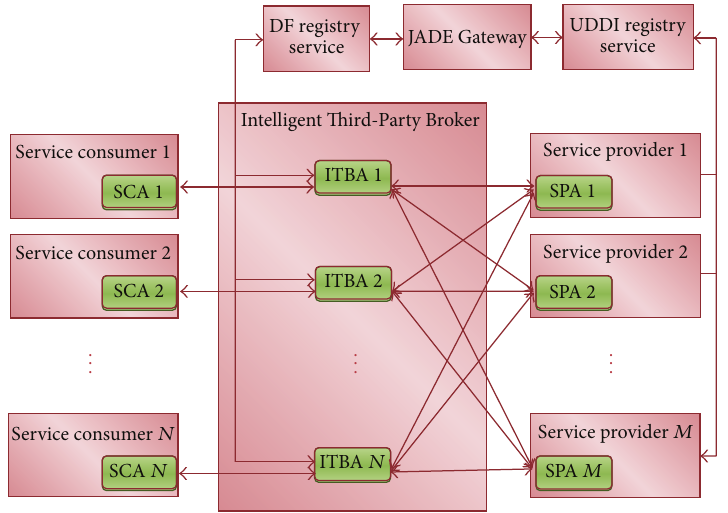
Figure 1: Architecture of cloud service negotiation